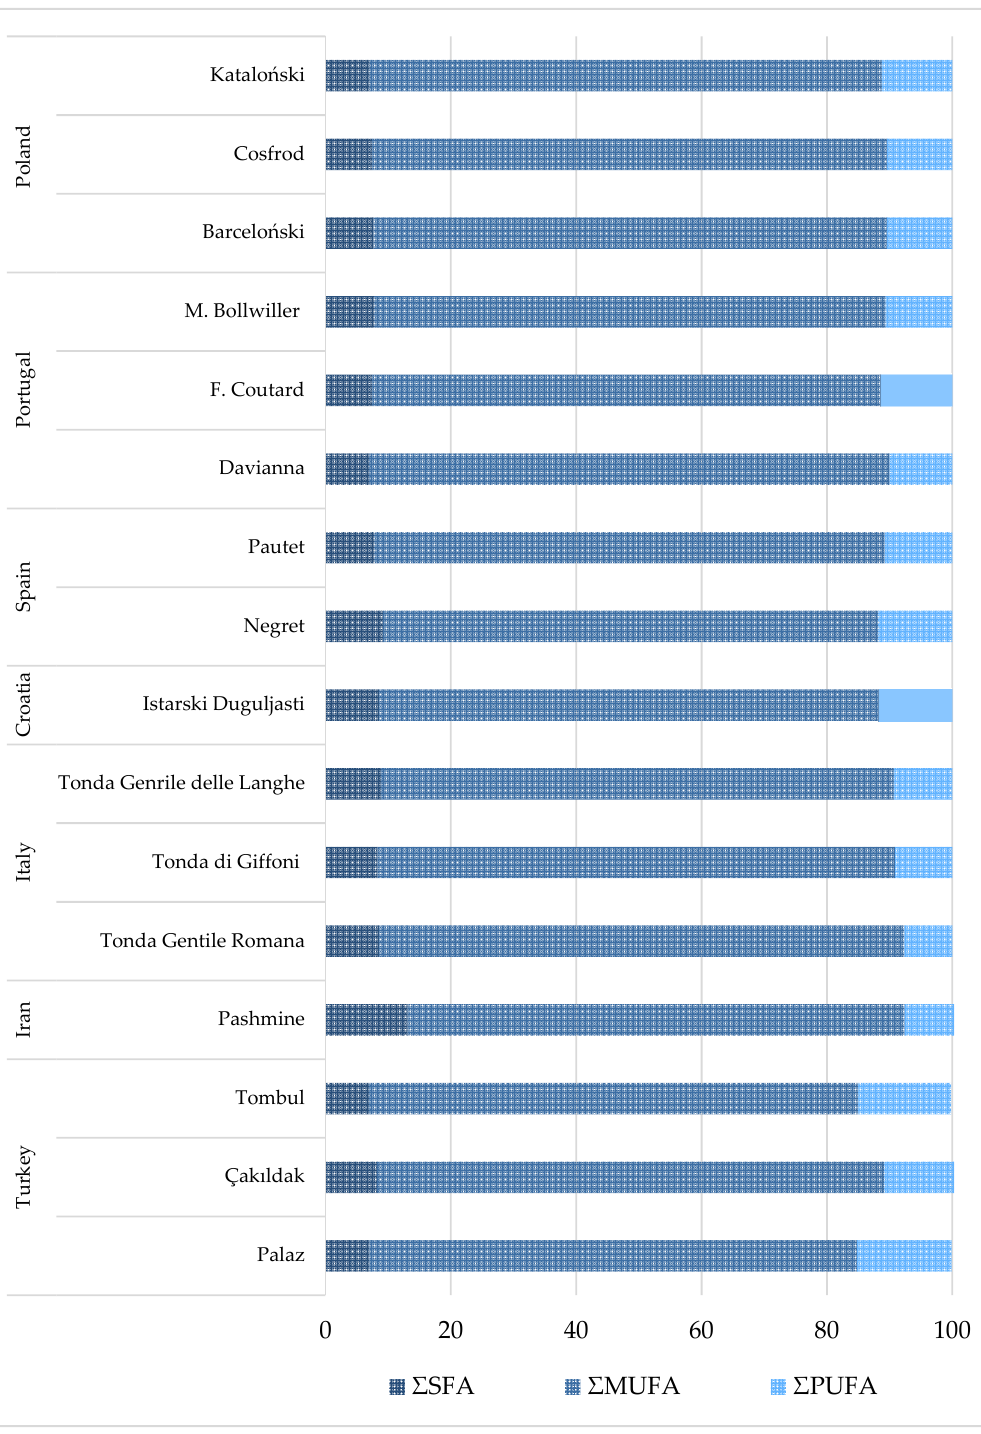
Figure 2. Fatty acid profile (%) in hazelnut from different cultivars and origins. Fatty acid profile, where: SFA—saturated fatty acids; MUFA—monounsaturated fatty acids. References: Poland: Król et al. [33]; Portugal: Oliveira et al. [9]; Spain: Rovira et al. [50]; Croatia: Vujevic et al. [67]; Italy: Bacchetta et al. [54]; Iran: Rezaei et al. [33]; Turkey: Koksal et al. [27].